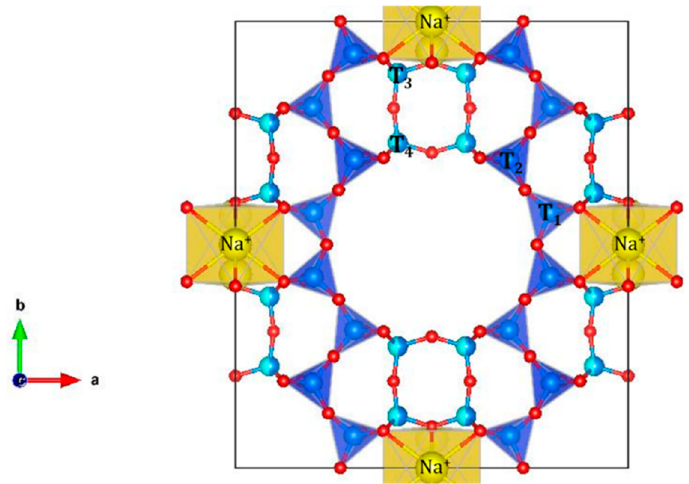
Figure 6. Mordenite viewed along [001] direction. The main channel is shown [12-ring 0.65 × 0.7 nm]. The Na + cations (yellow) and T-sites of NaMOR according to IZA database.